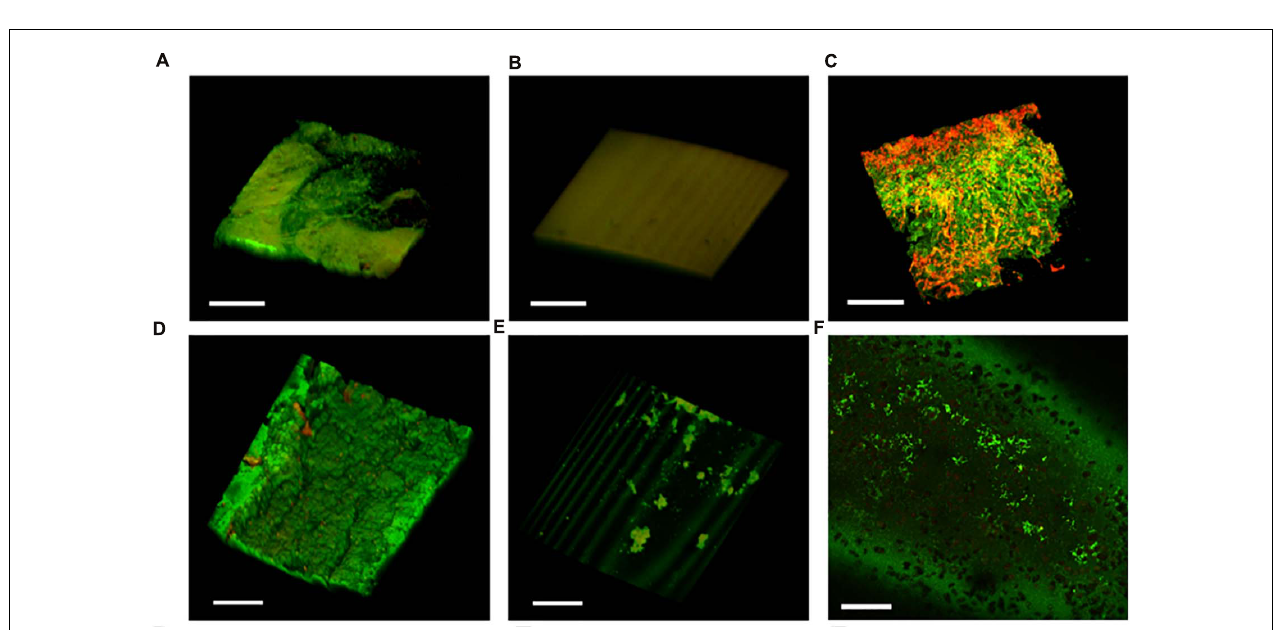
FIGURE 8 | Bacterial adhesion and biofilm buildup on the catheter. Confocal laser scanning microscopy analysis of the catheter balloon (top row) and luminal surface of catheter shafts (bottom row) after termination on day 3. The control catheter showed widespread biofilm formation on the (A) balloon and (D) catheter shaft. (B) No bacteria were visible on the interpenetrating polymer network (IPN)-C balloons, (E) but colonies of environmental contaminants were occasionally observed on the IPN-C shafts. The BIP-Cs were characterized by moderate amounts of bacteria on the (C) balloon and (F) shafts. (C) BIP-Cs were also covered with considerable amounts of mucus and epithelial debris (red). Bacteria were stained with Filmtracer LIVE/DEAD stain. Scale bar = 100 µ m.